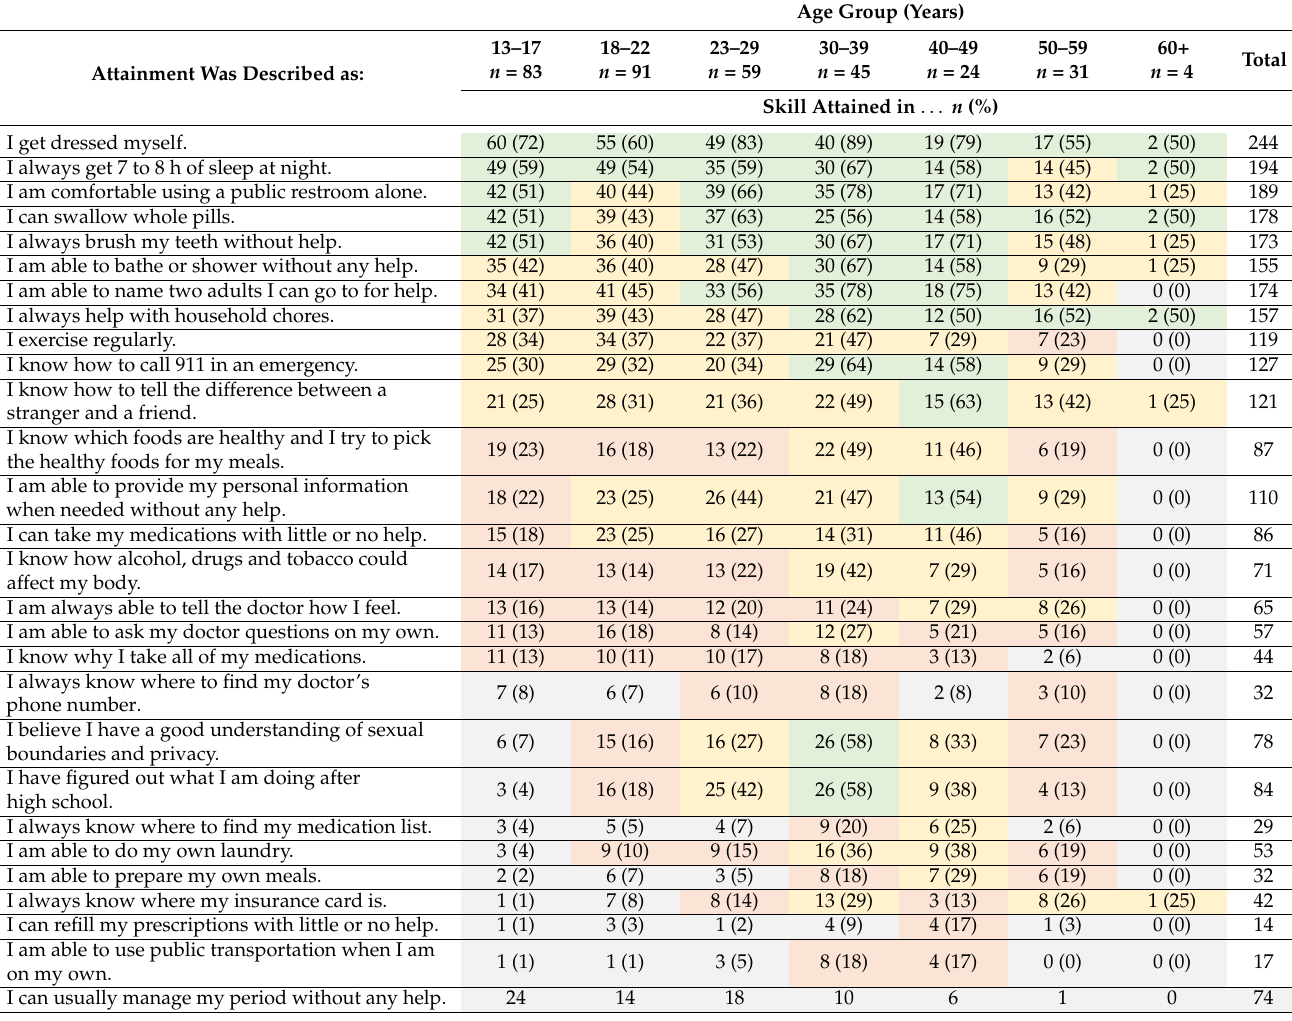
Table 5. Independence skills attained by age group of 337 patients with Down syndrome age 13+ years in the MGH